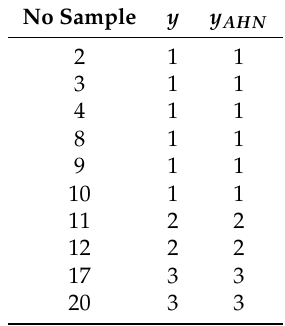
Table A4. Comparison between the predicted values y AHN and the target values y